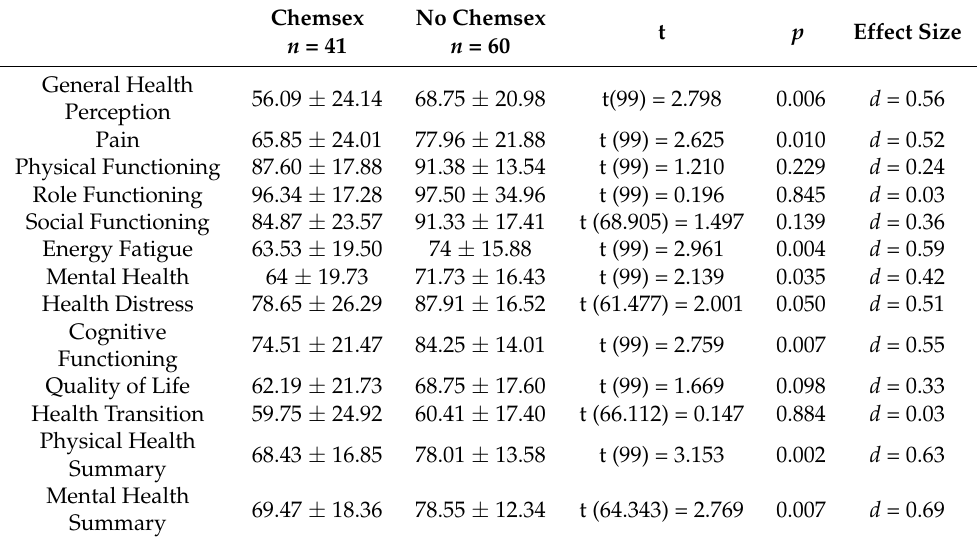
Table 7. Differences in Health-Related Quality of Life (HRQoL) between participants who practiced Chemsex and those who did not.